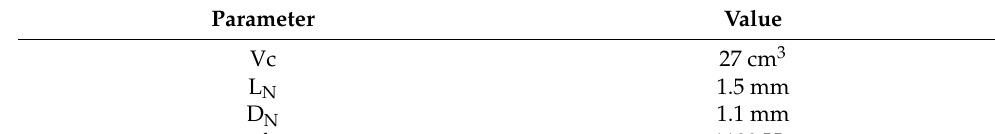
Table 2. Helmholtz resonator parameters.